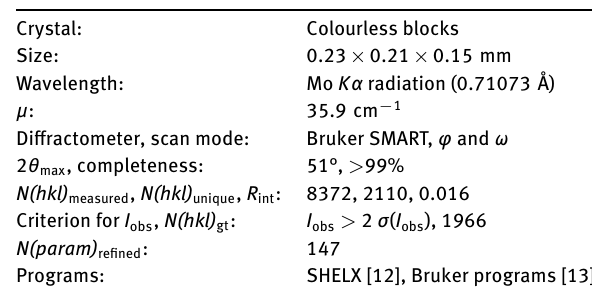
Table 1: Data collection and